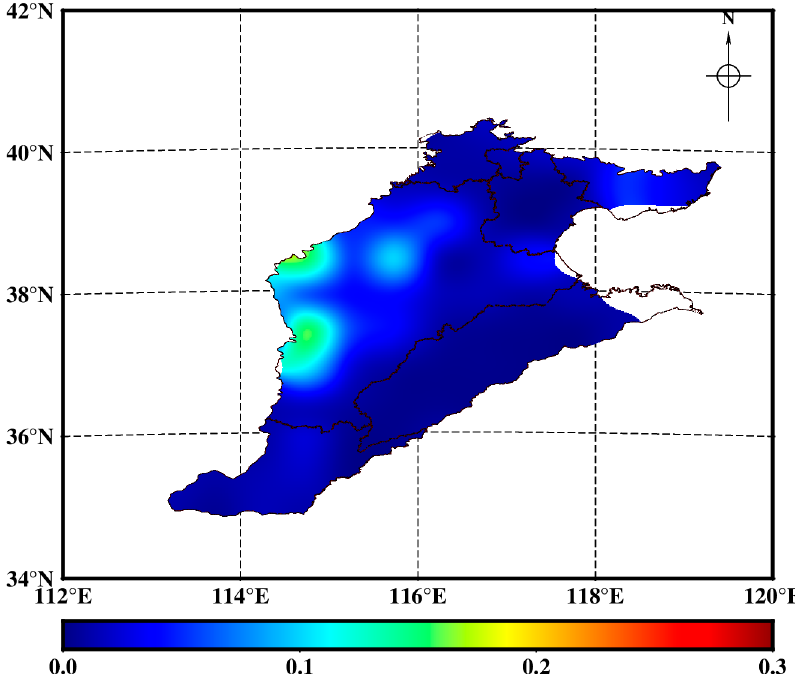
Figure 5. The root mean square errors (RMSEs) between the simulated and measured shallow groundwater storage changes.